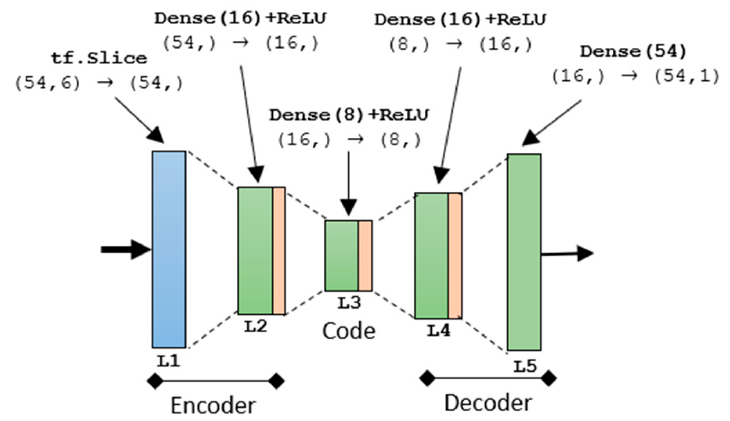
Figure 4. 5-layer Autoencoder Implementation.